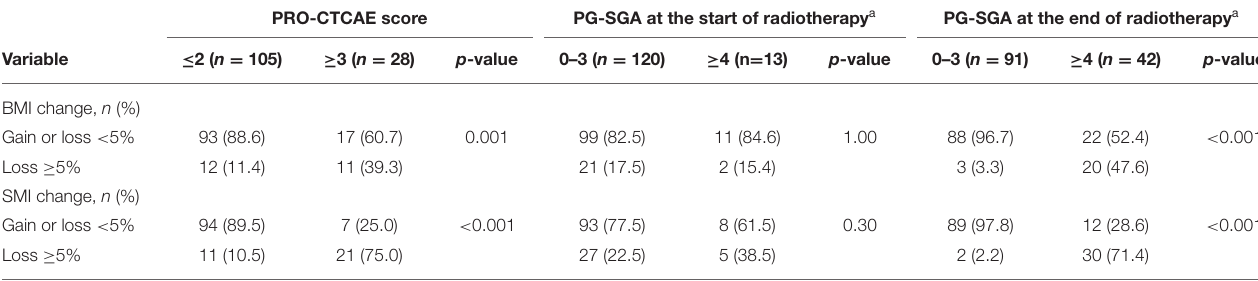
TABLE 2 | Body mass index and skeletal muscle index changes by PRO-CTCAE and PG-SGA. PRO-CTCAE score PG-SGA at the start of radiotherapy a PG-SGA at the end of radiotherapy